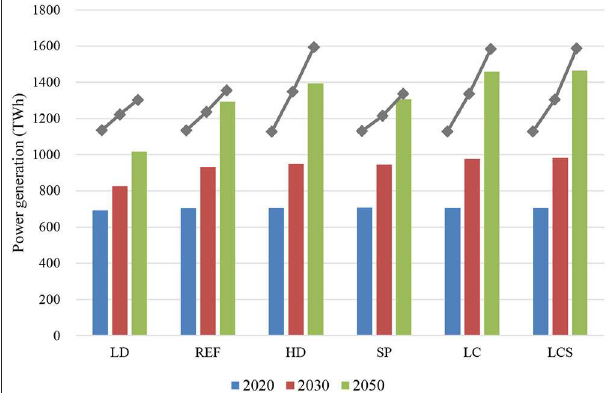
FIGURE 7 | The flexibility requirement and supply in six scenarios (histogram for flexibility requirement, line graph for flexibility supply).